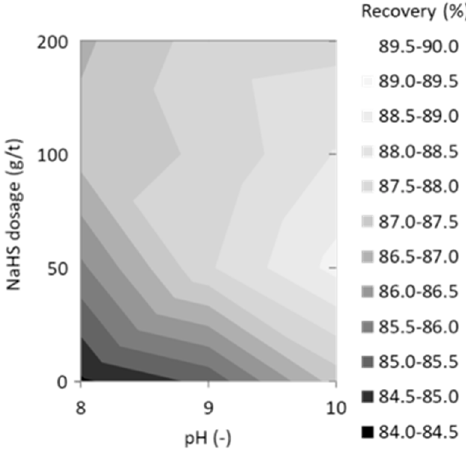
g/t at ( a ) pH 8, ( b ) pH 9, and ( c ) pH 10.